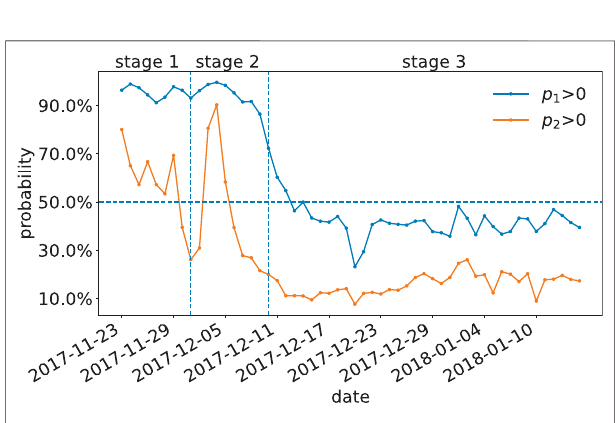
FIGURE 10 | The probability of generating positive pro fi t in selling a kitty each day. Dotted lines separates the stage 1, 2 and 3.